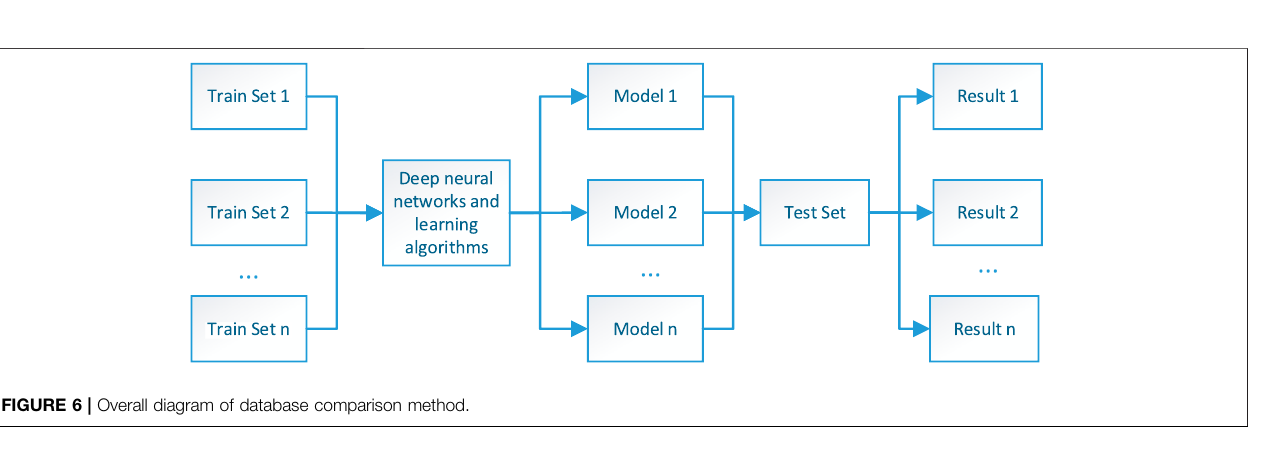
FIGURE 5 | Input/output of the algorithm in 2D arithmetic and Density heat map of BEVD sampling results.